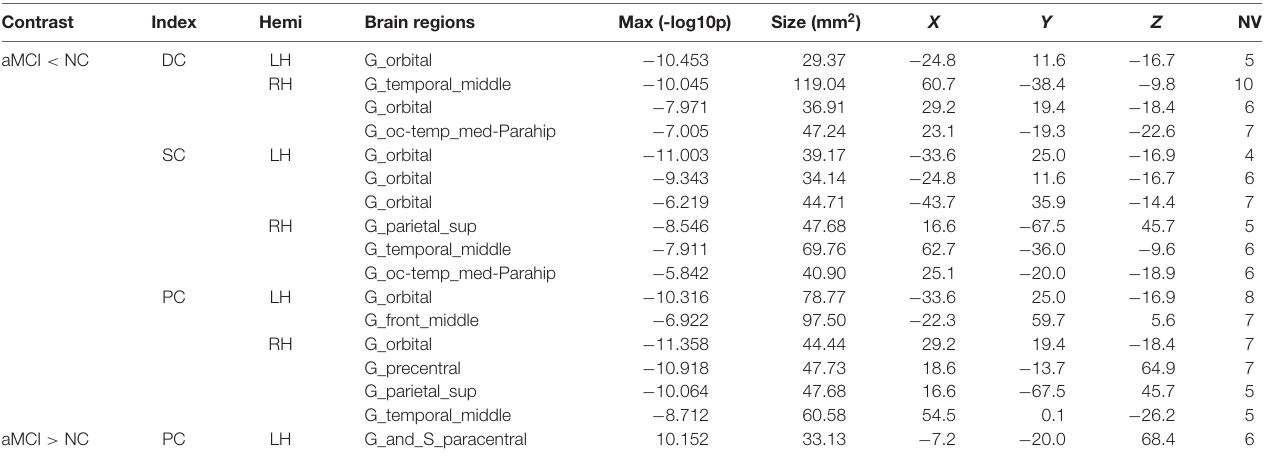
TABLE 3 | Full list of brain regions with significant centralities differences between aMCI and NC.